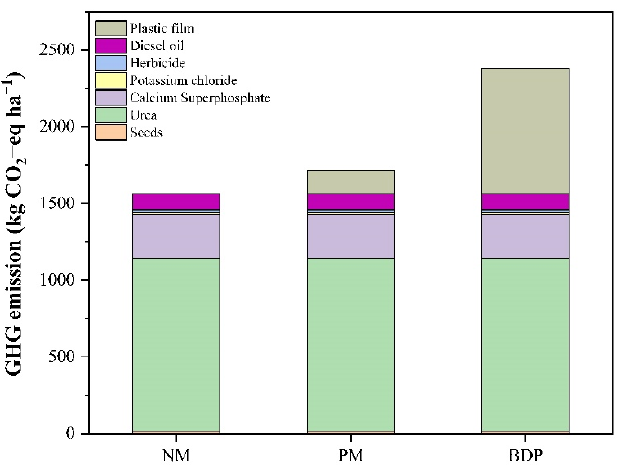
Figure 2. The GHG emissions associated with agricultural input in NM, PM and BDP cultivation systems.